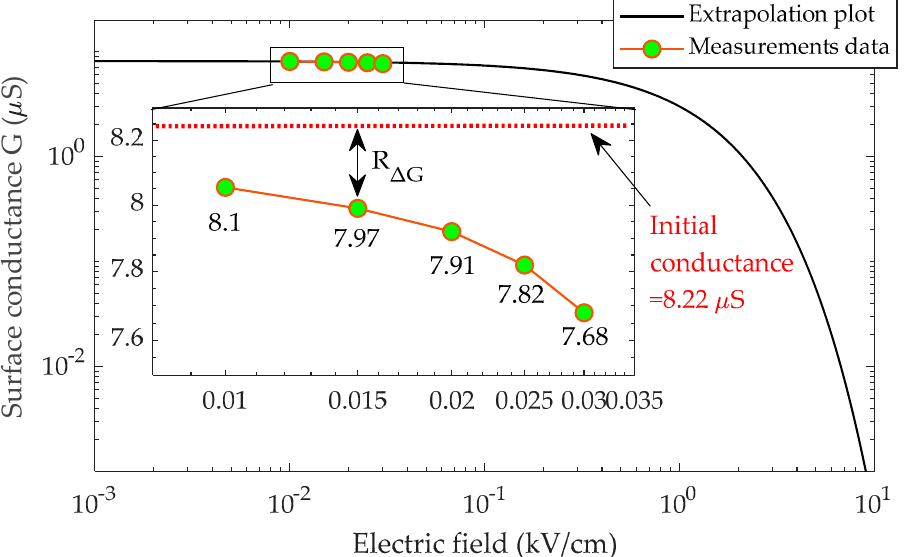
Figure 8. Relationship between the conductance and electric field for insulator type I.